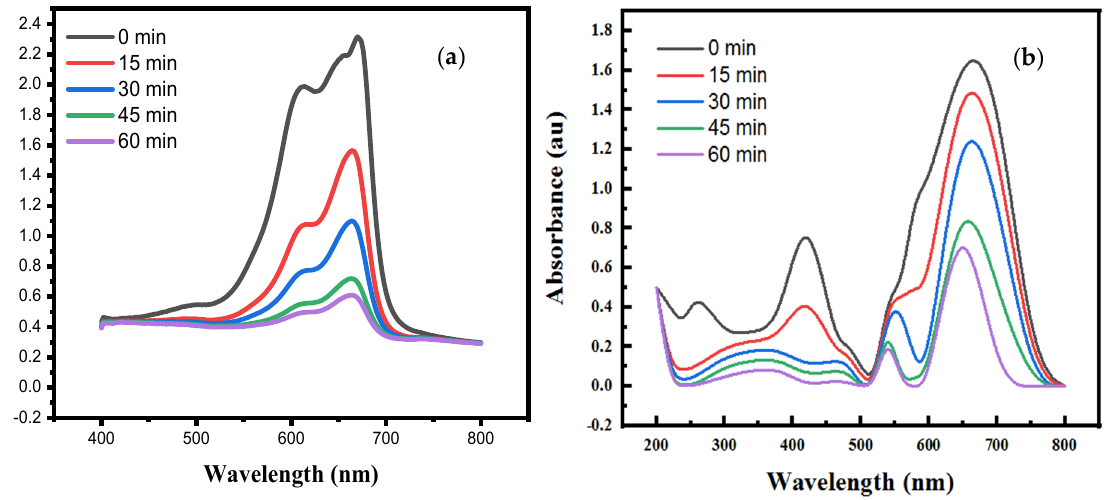
Figure 7. UV-vis profiles of dye solution after different UV exposure times in the presence of ( a ) coated fabric sample P1 and ( b ) coated fabric sample P2.